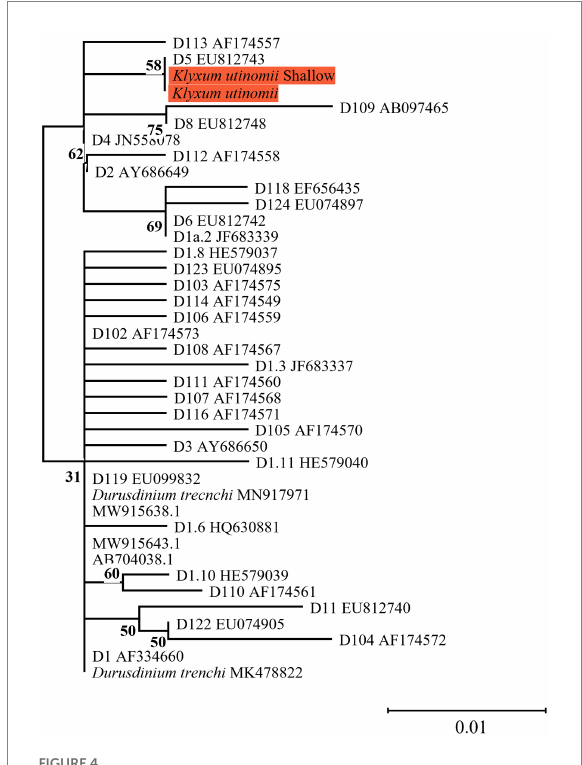
FIGURE 4 Phylogenetic relationship of the genus Durusdinium (previously named clade D) based on ITS2 rDNA sequences (270 bp), under the K2P model. The maximum likelihood tree was reconstructed with IQ-TREE 2.1.3. ML bootstrap supports based on 1,000 replicates are indicated either above or below the corresponding branch. Orange color indicates new Symbiodiniaceae sequences that were obtained in the current study for which the host name is indicated rather than the algal genetic